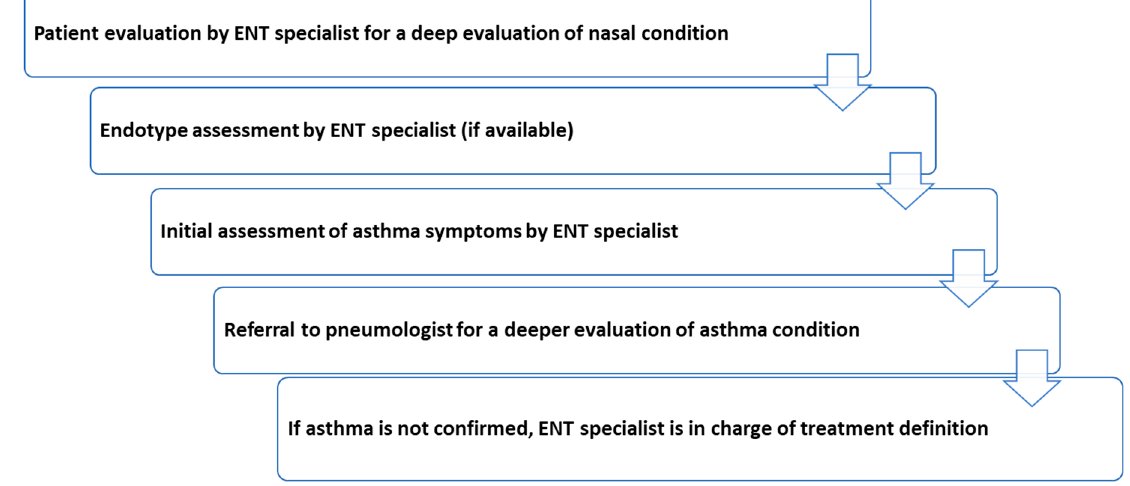
Figure 7. Summary of the third flow. ENT = otolaryngology.